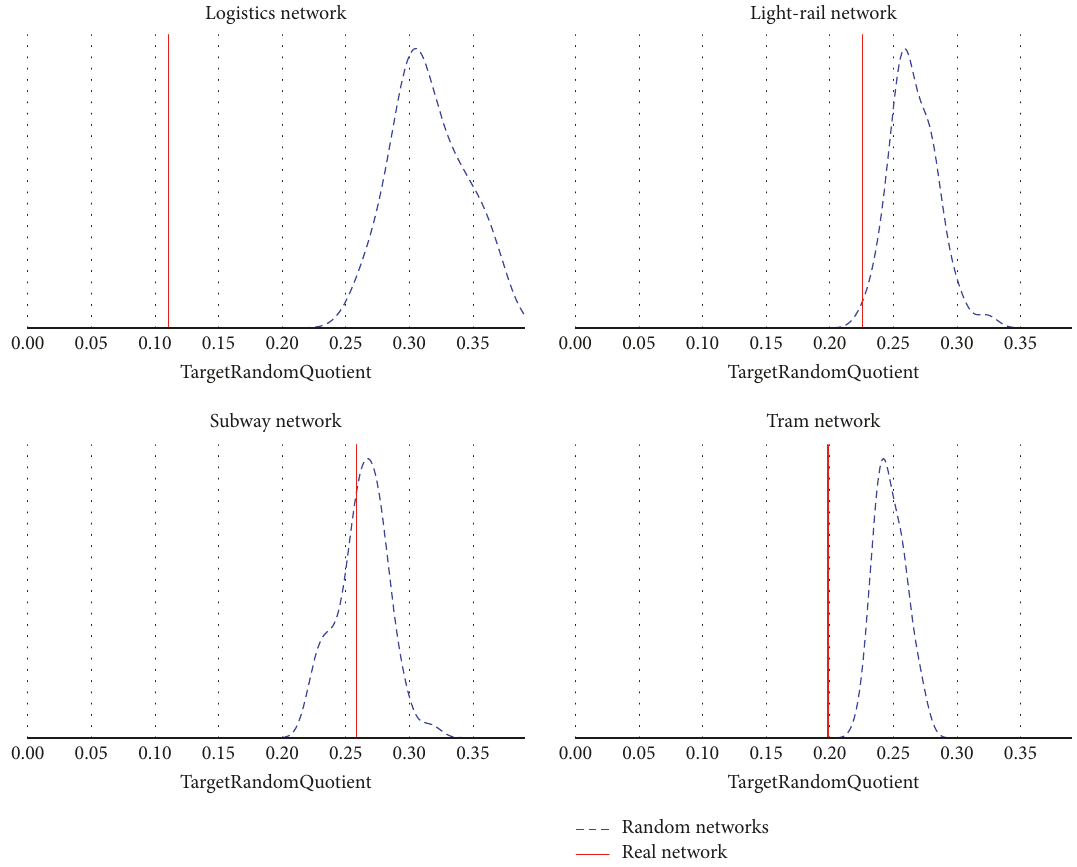
Figure 8: Comparison of difference between targeted/random attacks in real networks and their random counterparts (each of the 50 networks with the same number of nodes and links). The blue dashed curve is the kernel density estimation of TargetRandomQuotient in the random networks and the red vertical line indicates the TargetRandomQuotient for the real